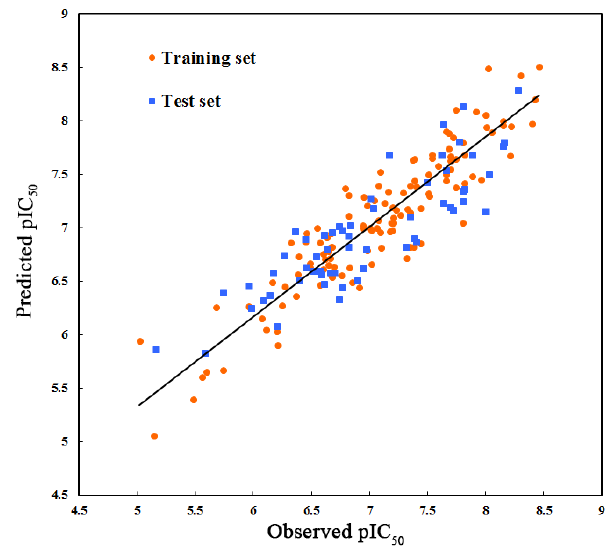
Figure 2. The ligand-based correlation plot of the predicted versus the actual pIC based on the comparative molecular similarity index analysis (CoMSIA) model. The solid line is the regression line for the fitted and predicted bioactivities of training compounds in the optimal CoMSIA